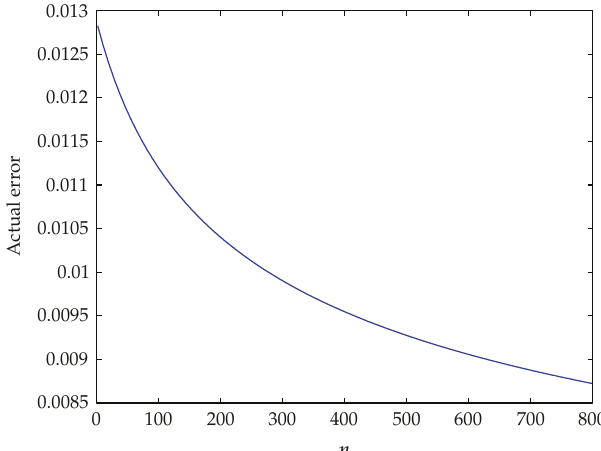
Figure 1: T he actual error, Δ n , for r n (cid:4) 1 / (cid:5) n (cid:2) log n (cid:3) 1 / 2 (cid:2) log log n (cid:3)(cid:6) and (cid:2) x,y (cid:3) (cid:4) (cid:2) − 1 , − 1 (cid:3) .